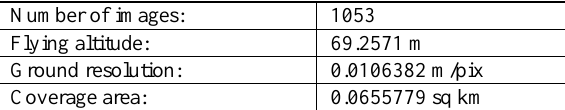
Table 1. Cameras mounted on the vehicle